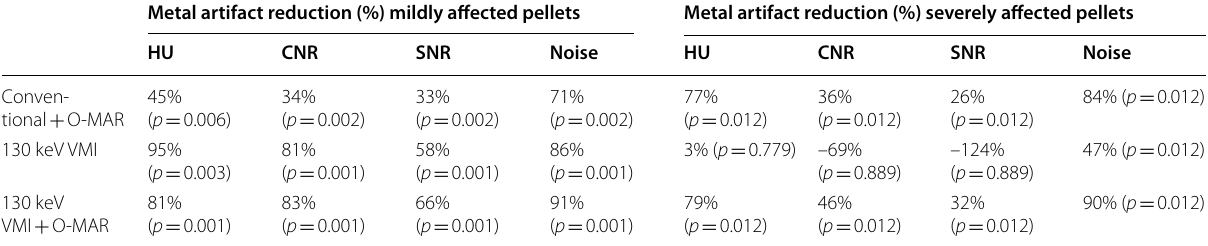
Table 3 Relative metal artifact reduction in CT values (HU), contrast-to-noise ratio, signal-to-noise ratio and noise in comparison to conventional (140kVp) images without O-MAR